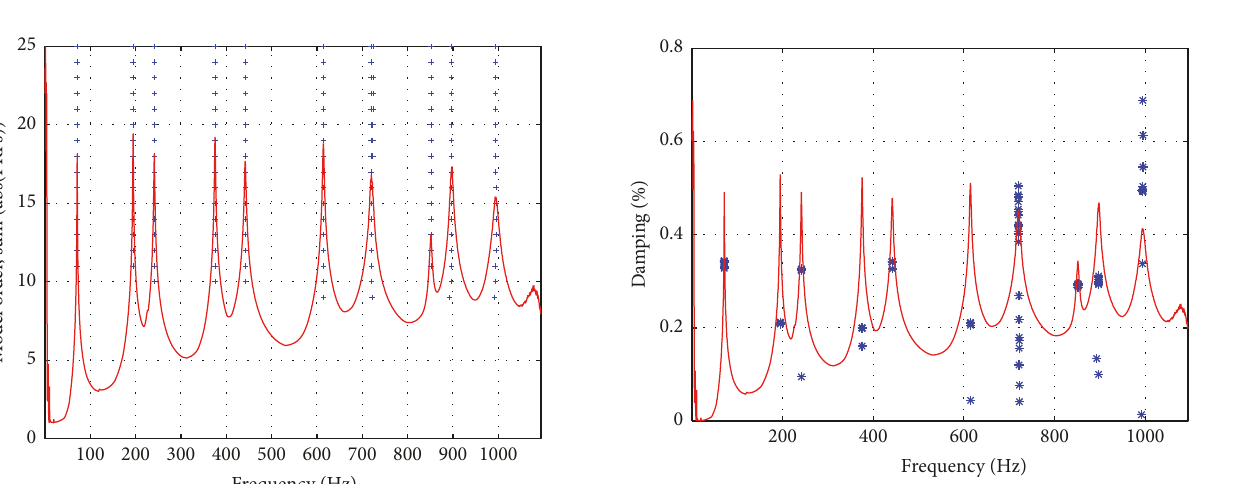
Figure6:Stabilizationdiagramforthenaturalfrequencies.Each“+” corresponds to an estimated frequency in the selected band, given the model order 𝑛 (ranging from 1 to 25).